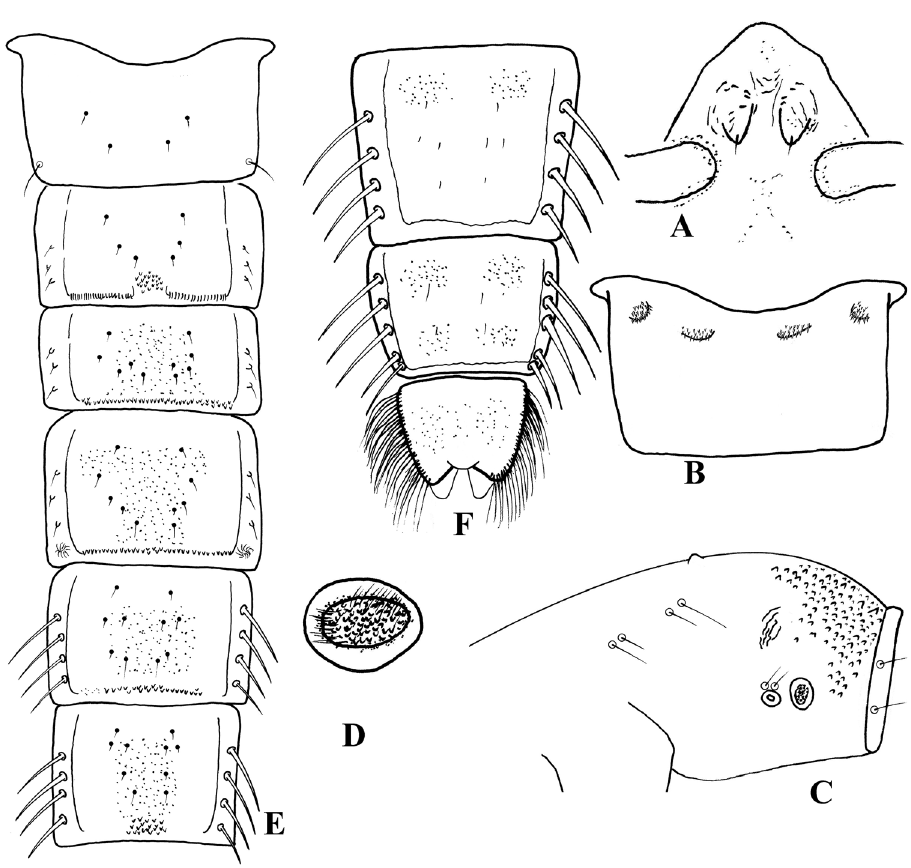
Figures 4. Harnischia curtilamellata. Pupae. A frontal apotome B sternite I C thorax, lateral view D basal ring E tergites I–VI F tergite VII–VIII and anal